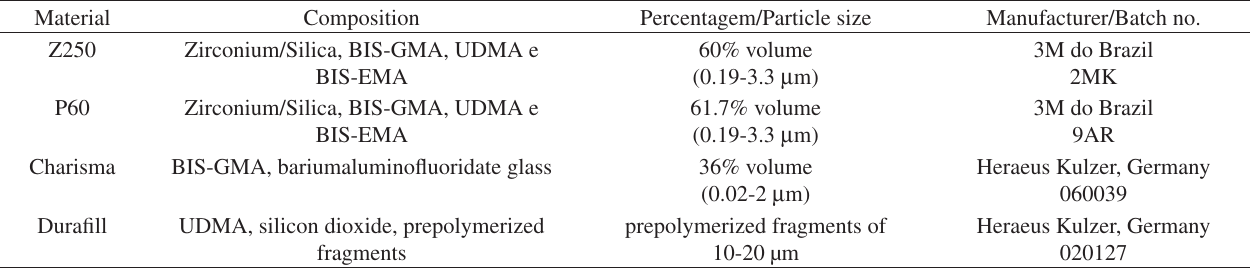
Table 2. Composite resins